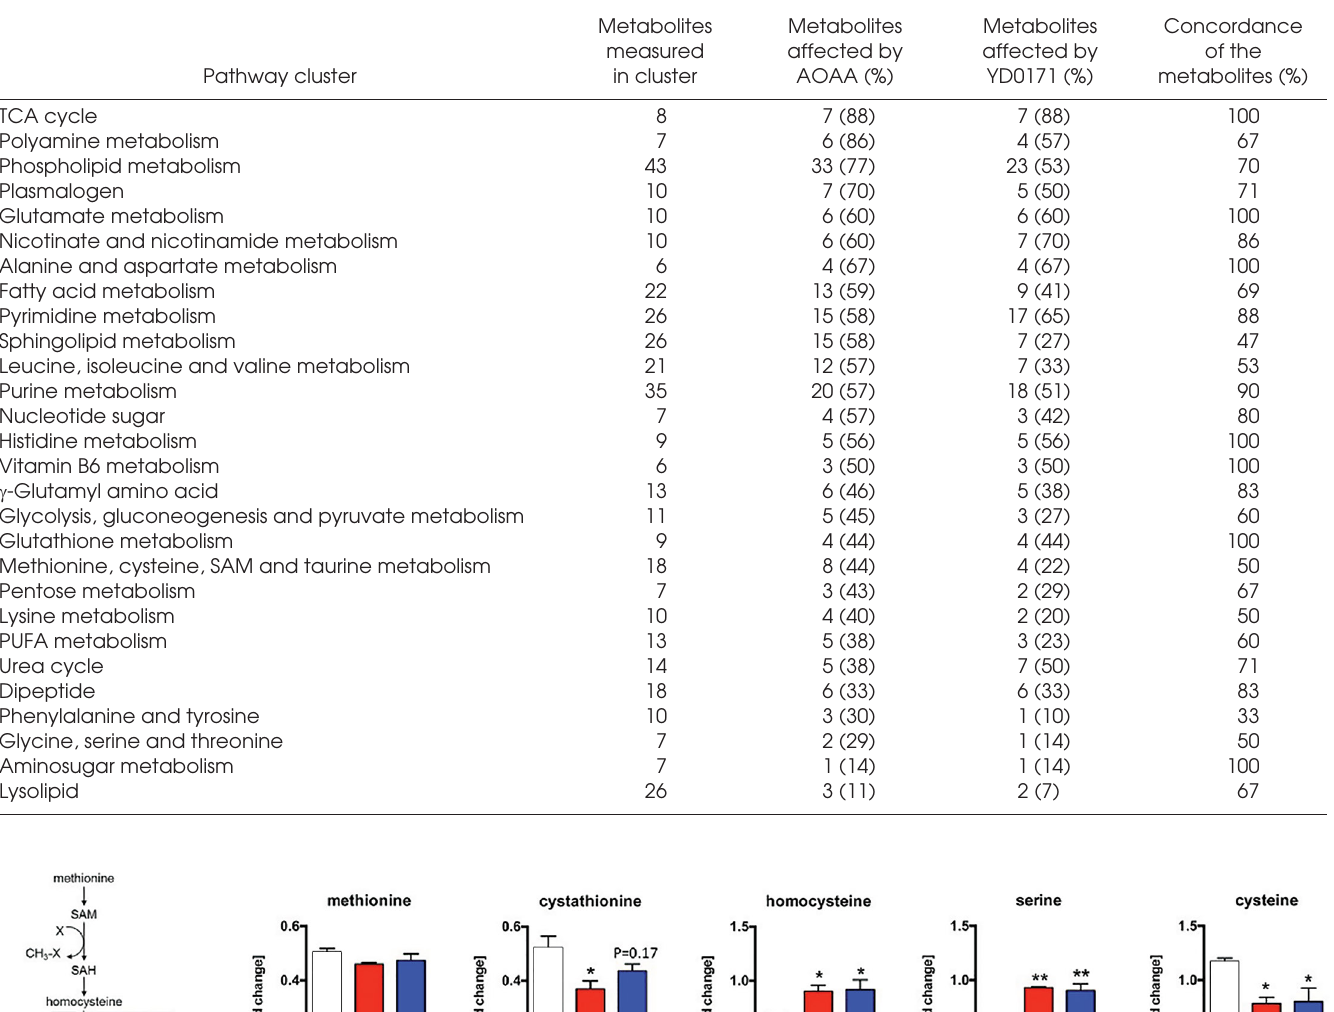
Pathway cluster